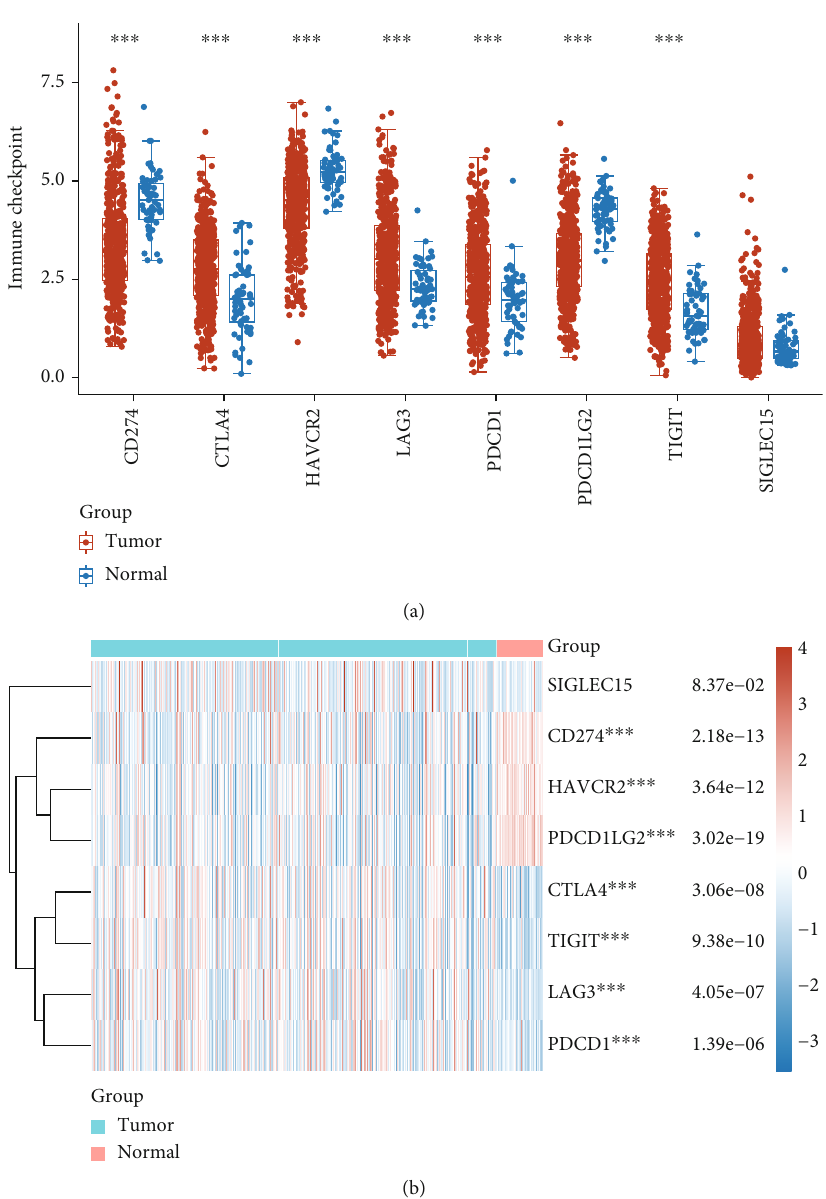
Figure 6: (a, b) The dysregulated expression of immune checkpoints in LUAD samples in contrast to nontumor specimens. ∗∗∗ p < 0 : 001